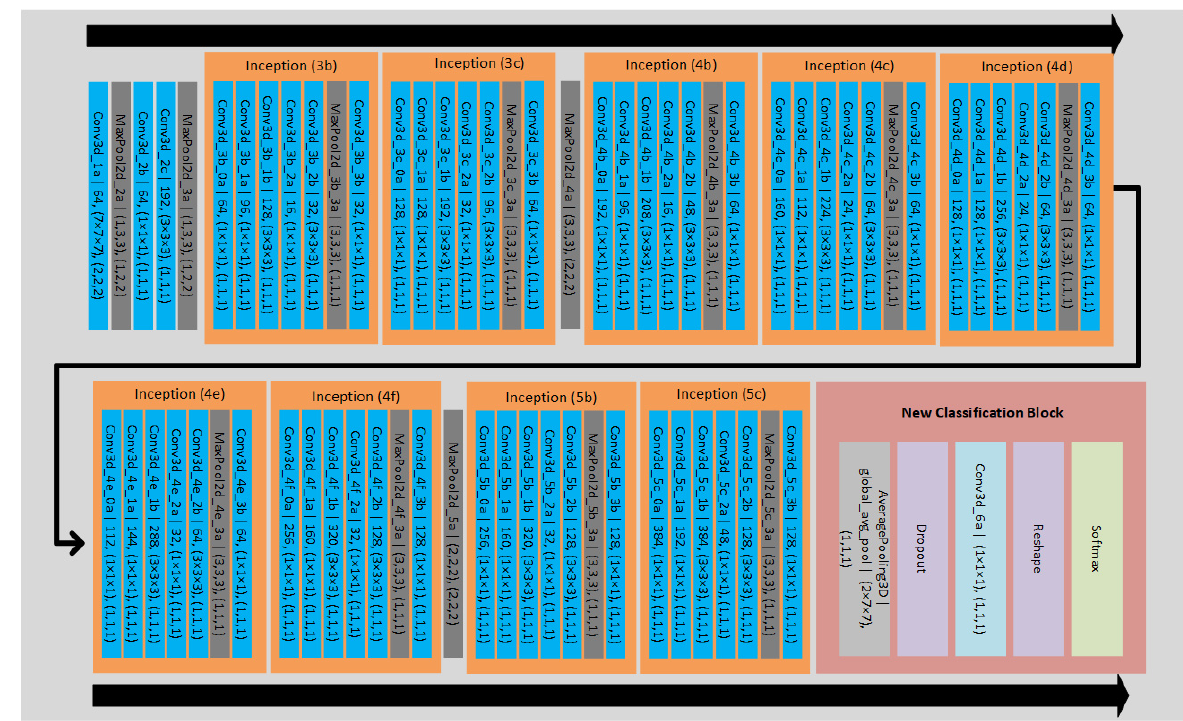
Figure 5. Implementation details of the model. Note that the architecture of each Conv3d layer shows the number of filters, size of the convolutional kernel, and stride. The architecture of each pooling layer includes the kernel size and stride.